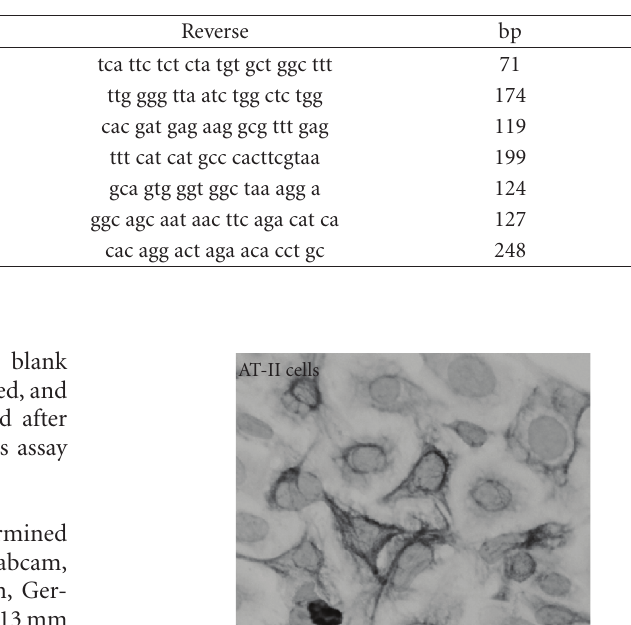
Table 1: Primer sequences for mRNA detection of the di ff erent gene products.